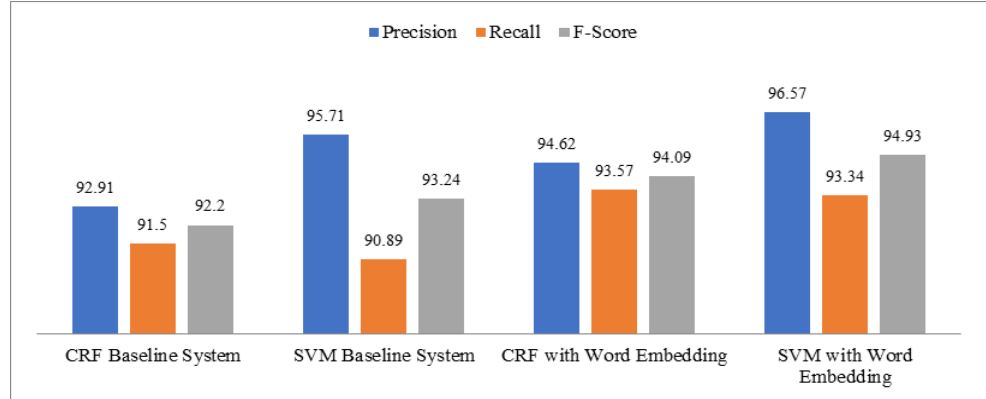
Figure 2. Comparison of CRF and SVM based NER System after Word Embedding